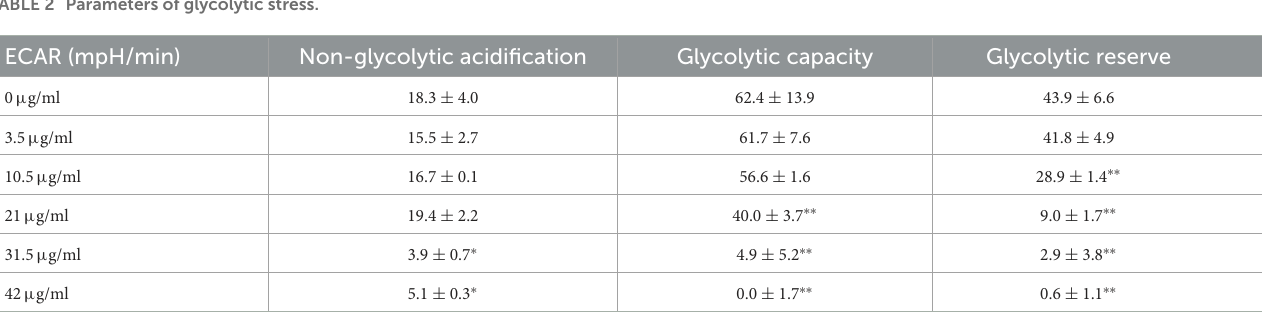
TABLE 2 Parameters of glycolytic